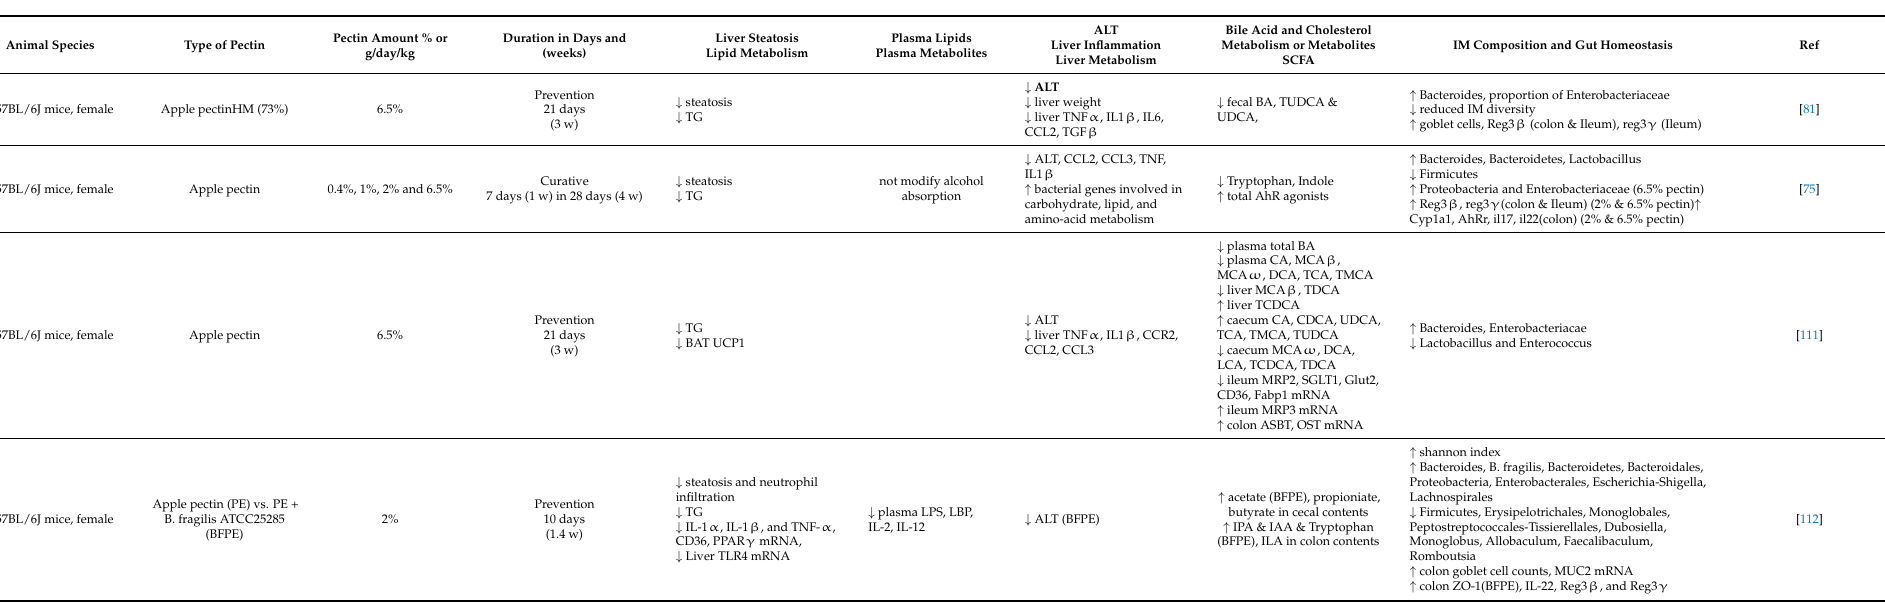
Table 3. Changes induced by a pectin-enriched diet to address liver injury in alcoholic liver disease. Summary of metabolic changes induced by pectin in studies addressing the improvement of liver damage in alcoholic liver